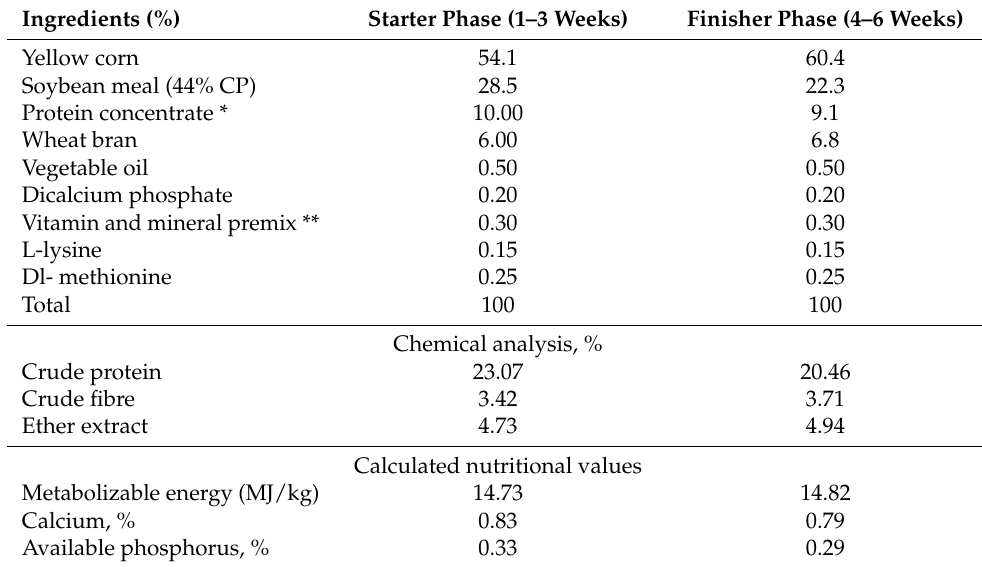
Table 2. Ingredients and chemical composition of the experimental